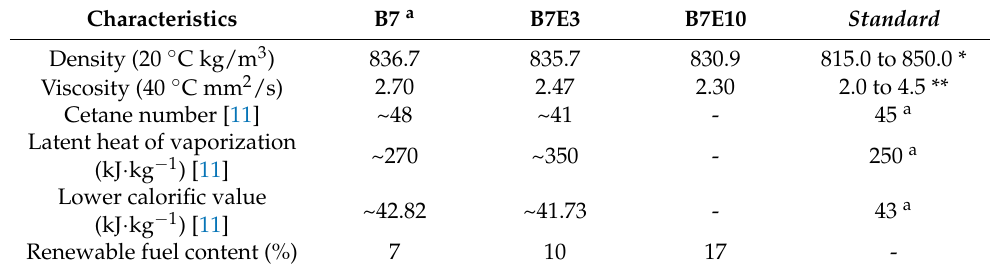
Table 1. Fuel specifications. Please confirm if the italics should be retained.